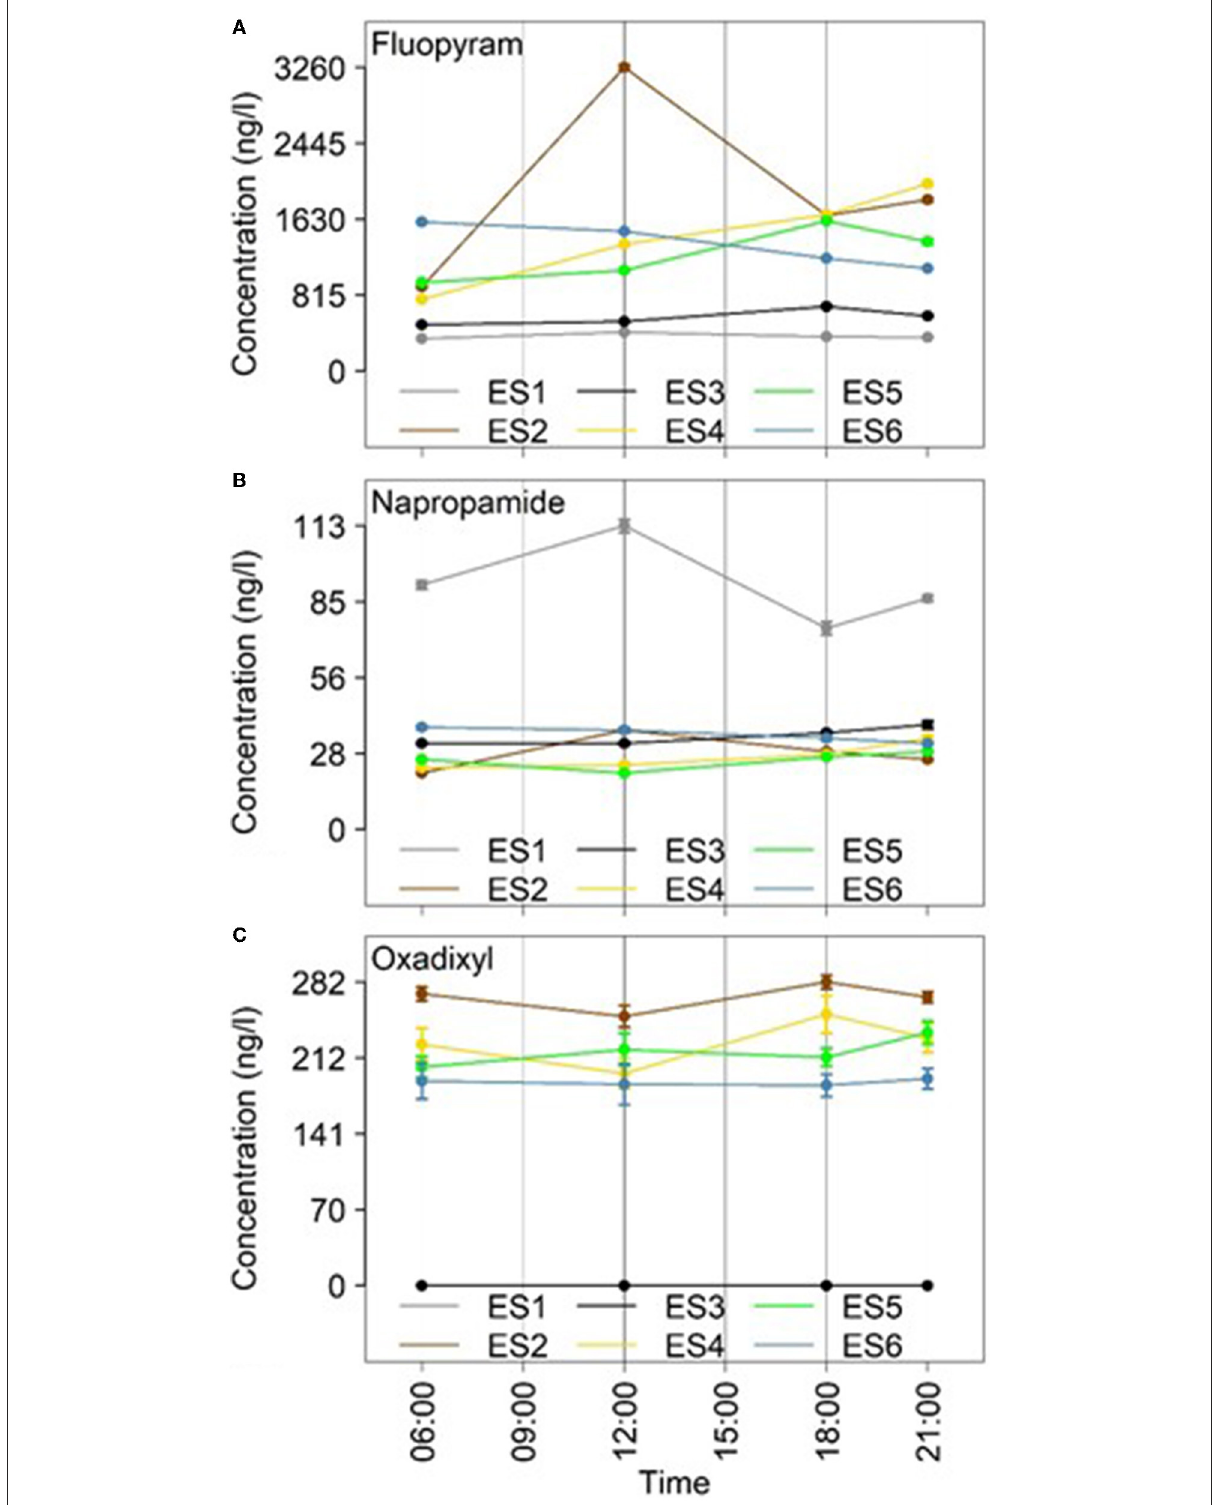
FIGURE6 Time series of concentrations in surface water for selected PPPs measured during the dry-day campaign across the catchment on August 12 th 2020. Data points are grouped by compound, colored by location and depicted over time. The vertical bars indicated the standard deviation of the measurements (mean concentration of 3 injections of the same sample). (A) Fungicide fluopyram, (B) herbicide napropamide, and (C) fungicide oxadixyl withdrawn from the Swiss market in